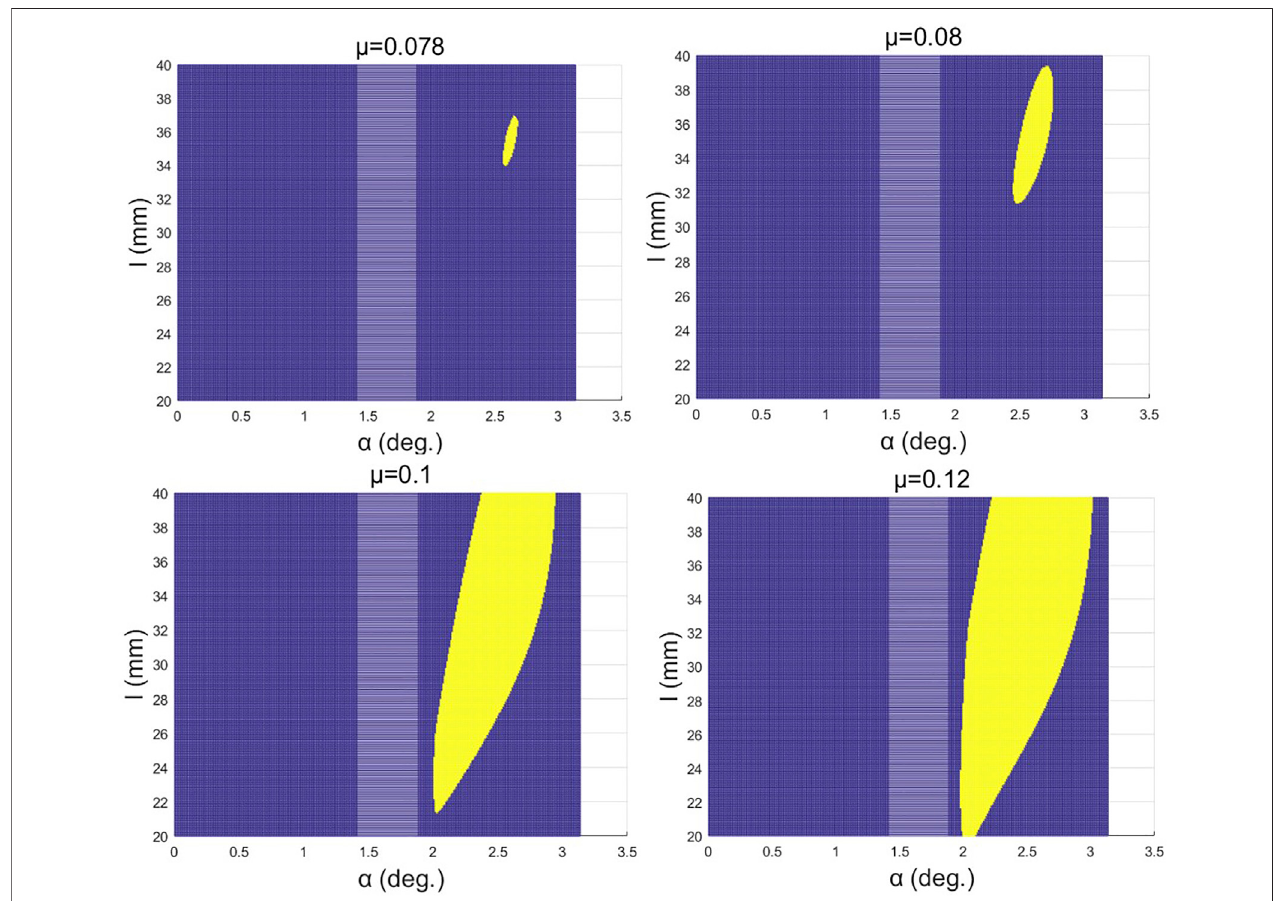
FIGURE 5 | Monotonicity of the cam pro fi le